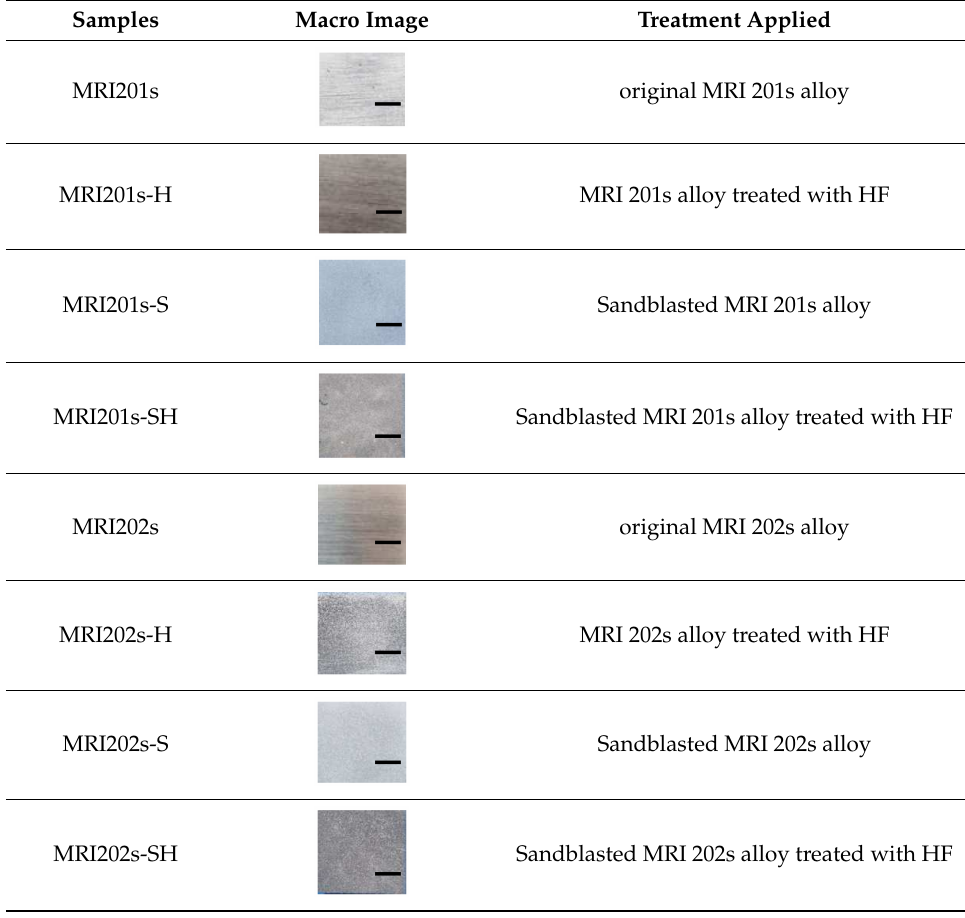
Table 2. Coding of experimental samples (scalebars from images are 5 mm